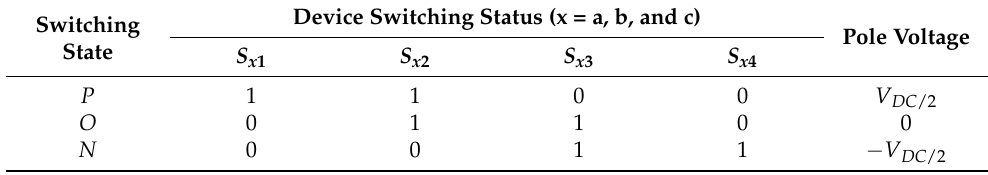
Figure 1. Configuration of the 3L-NPCI with IPMSM drive. Table 1. Switching states of 3L-NPC